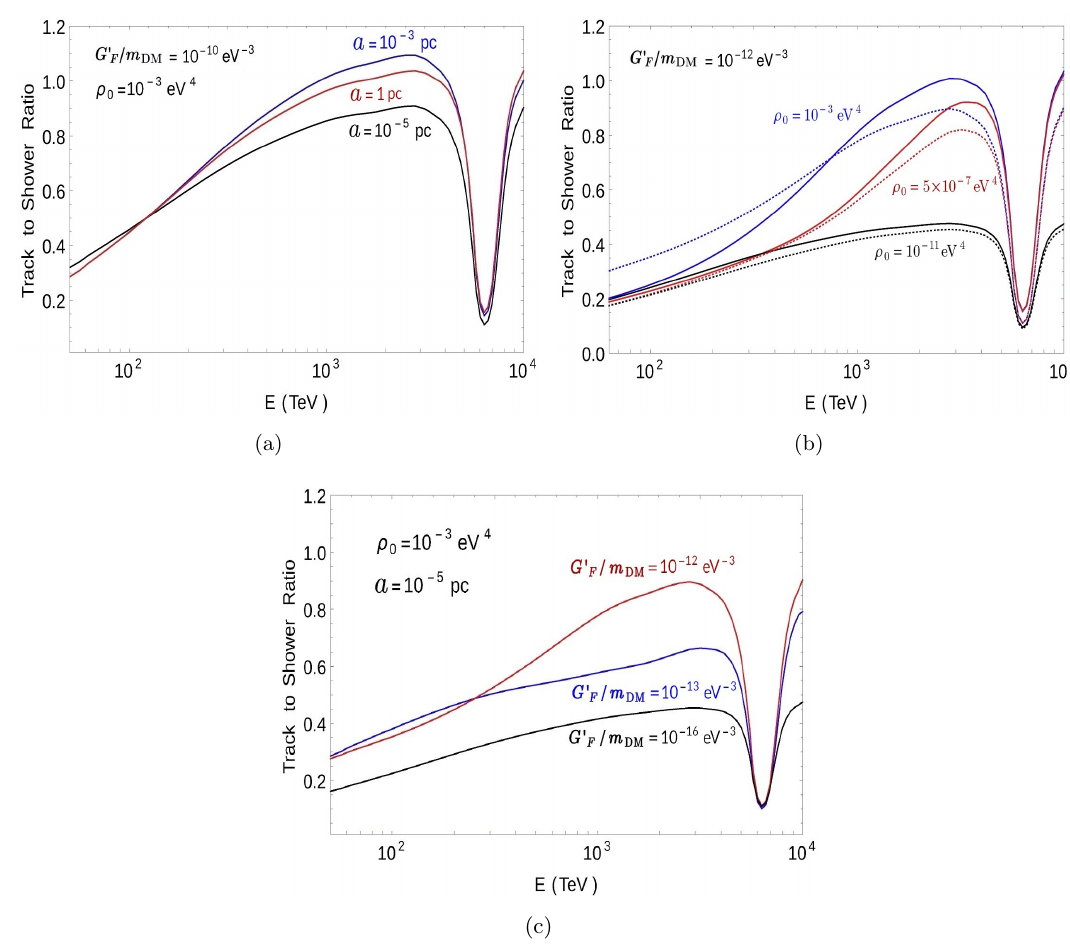
, and (c) G 0 /m DM . In (b), the solid and dotted 0 F